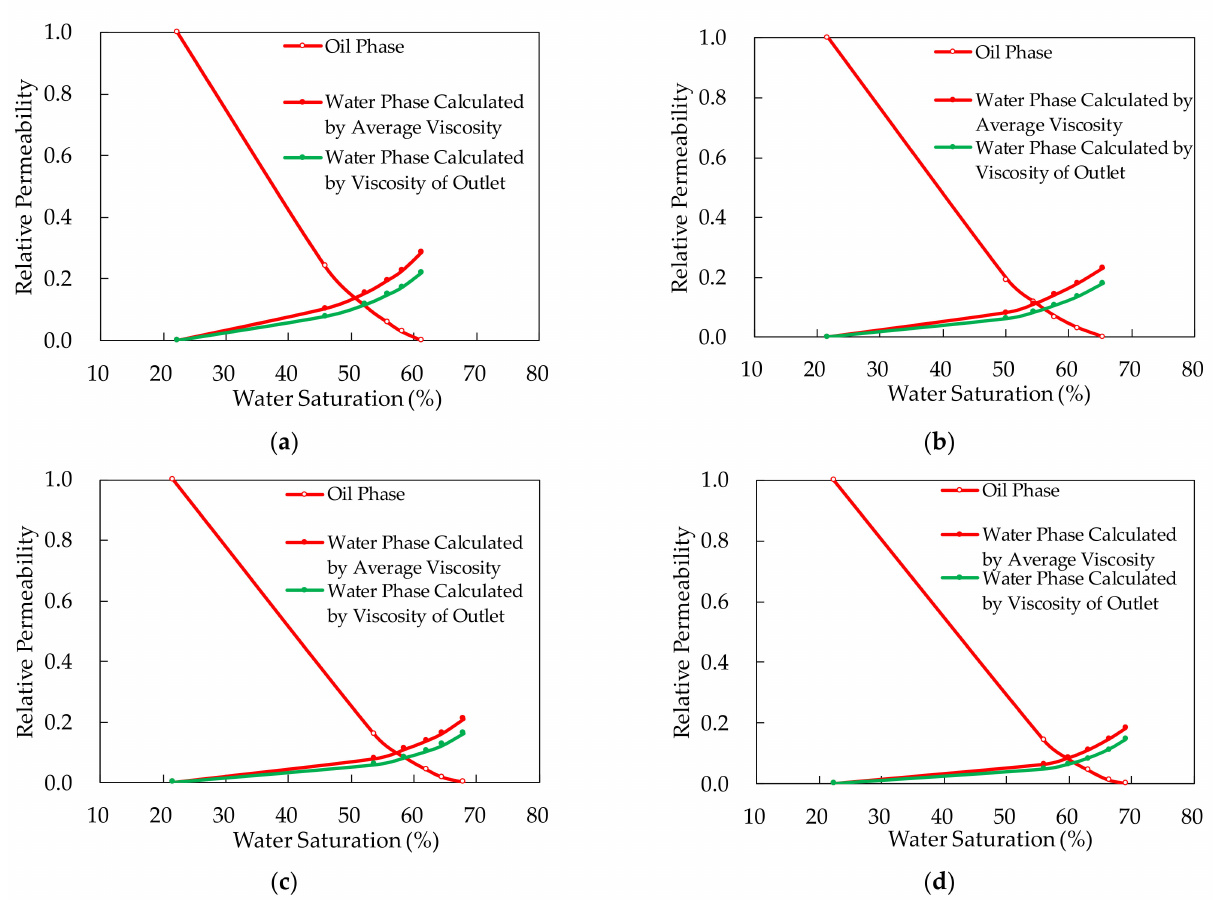
Figure 9. Polymer solution relative permeability curves calculated by different viscosity methods. ( a ) Experiment RP-1 in which the polymer concentration is 500 mg/L; ( b ) Experiment RP-2 in which the polymer concentration is 1250 mg/L; ( c ) Experiment RP-3 in which the polymer concentration is 1750 mg/L; ( d ) Experiment RP-4 in which the polymer concentration is 2000